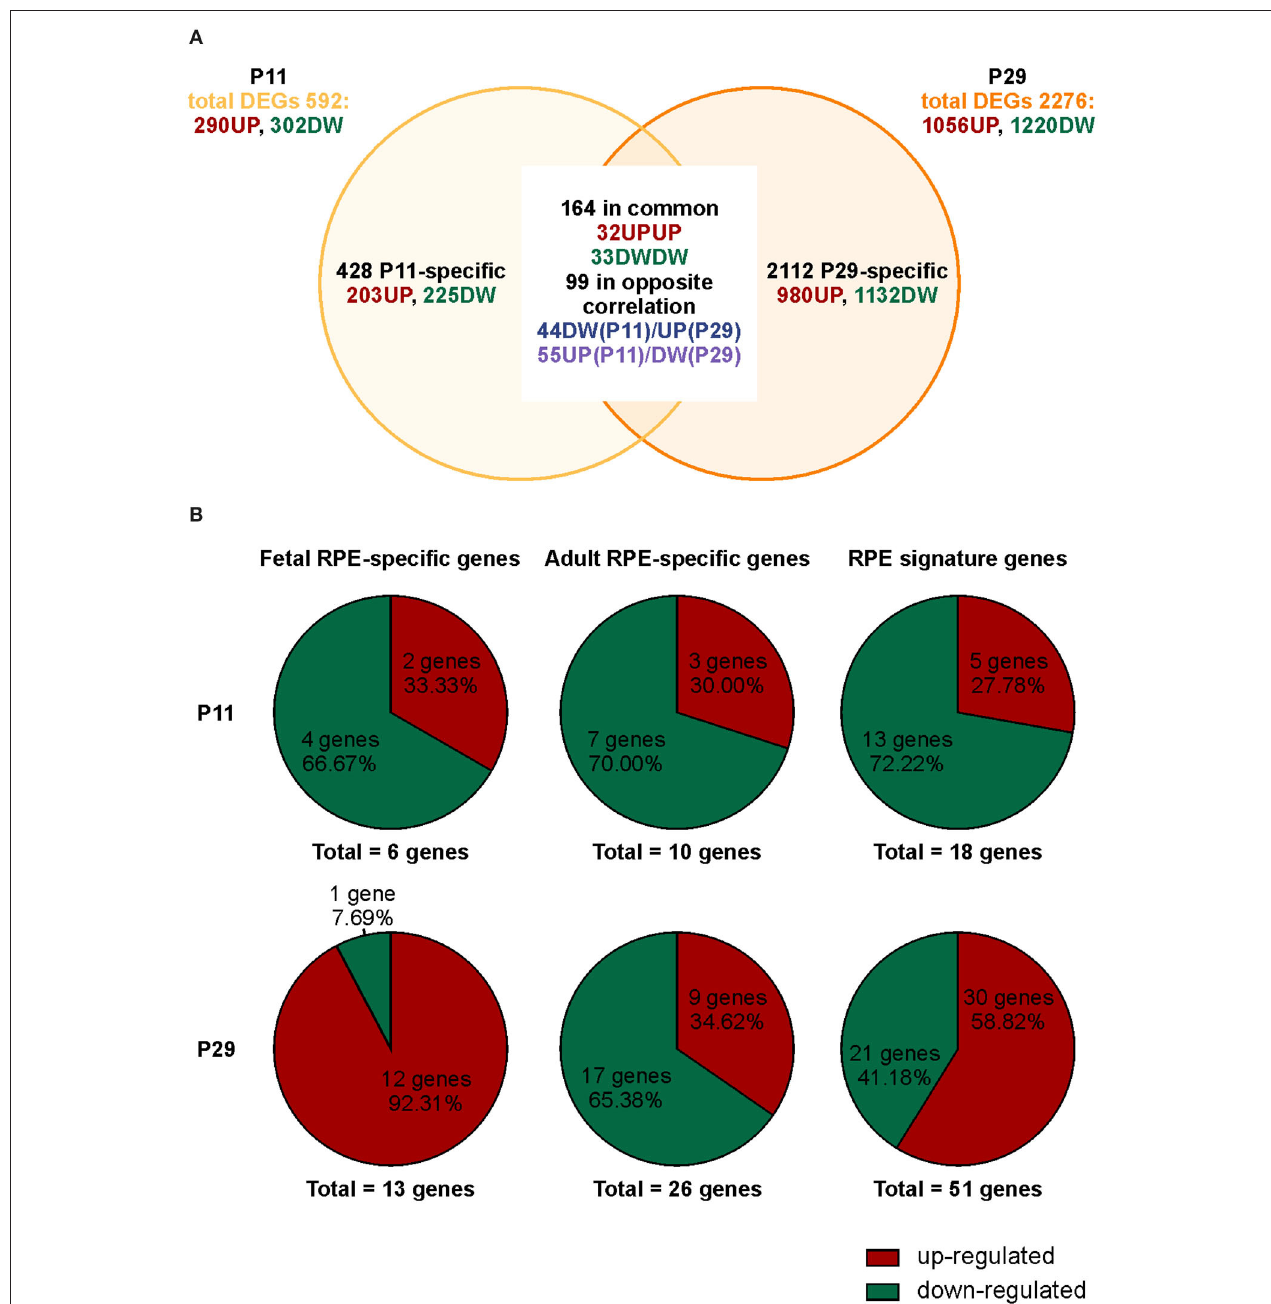
FIGURE 1 | Loss of Bbs8 induces a switch in RPE-specific gene expression from P11 to P29. (A) Venn diagram showing differentially expressed genes (DEGs) obtained via transcriptomic analysis. The number of specific and common DEGs and the orientation of expression are shown. DW, down-regulated; UP, up-regulated. (B) Pie charts depicting % up- or down-regulated genes for three different categories; fetal RPE-specific genes, adult RPE-specific genes and RPE signature genes. At P11 all categories have an increased down-regulation. At P29 fetal RPE-specific genes and RPE signature genes become up-regulated.